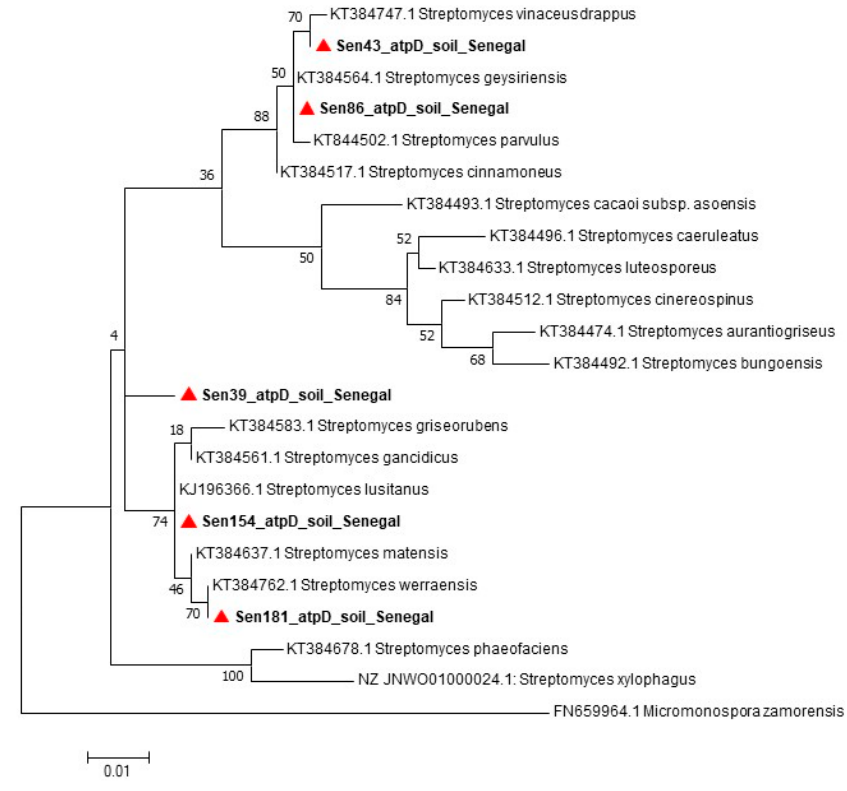
Figure 3. Maximum-likelihood phylodendrogram of Streptomyces spp., including the species isolated in the present study based on the partial 466-bp sequence of the atpD gene.